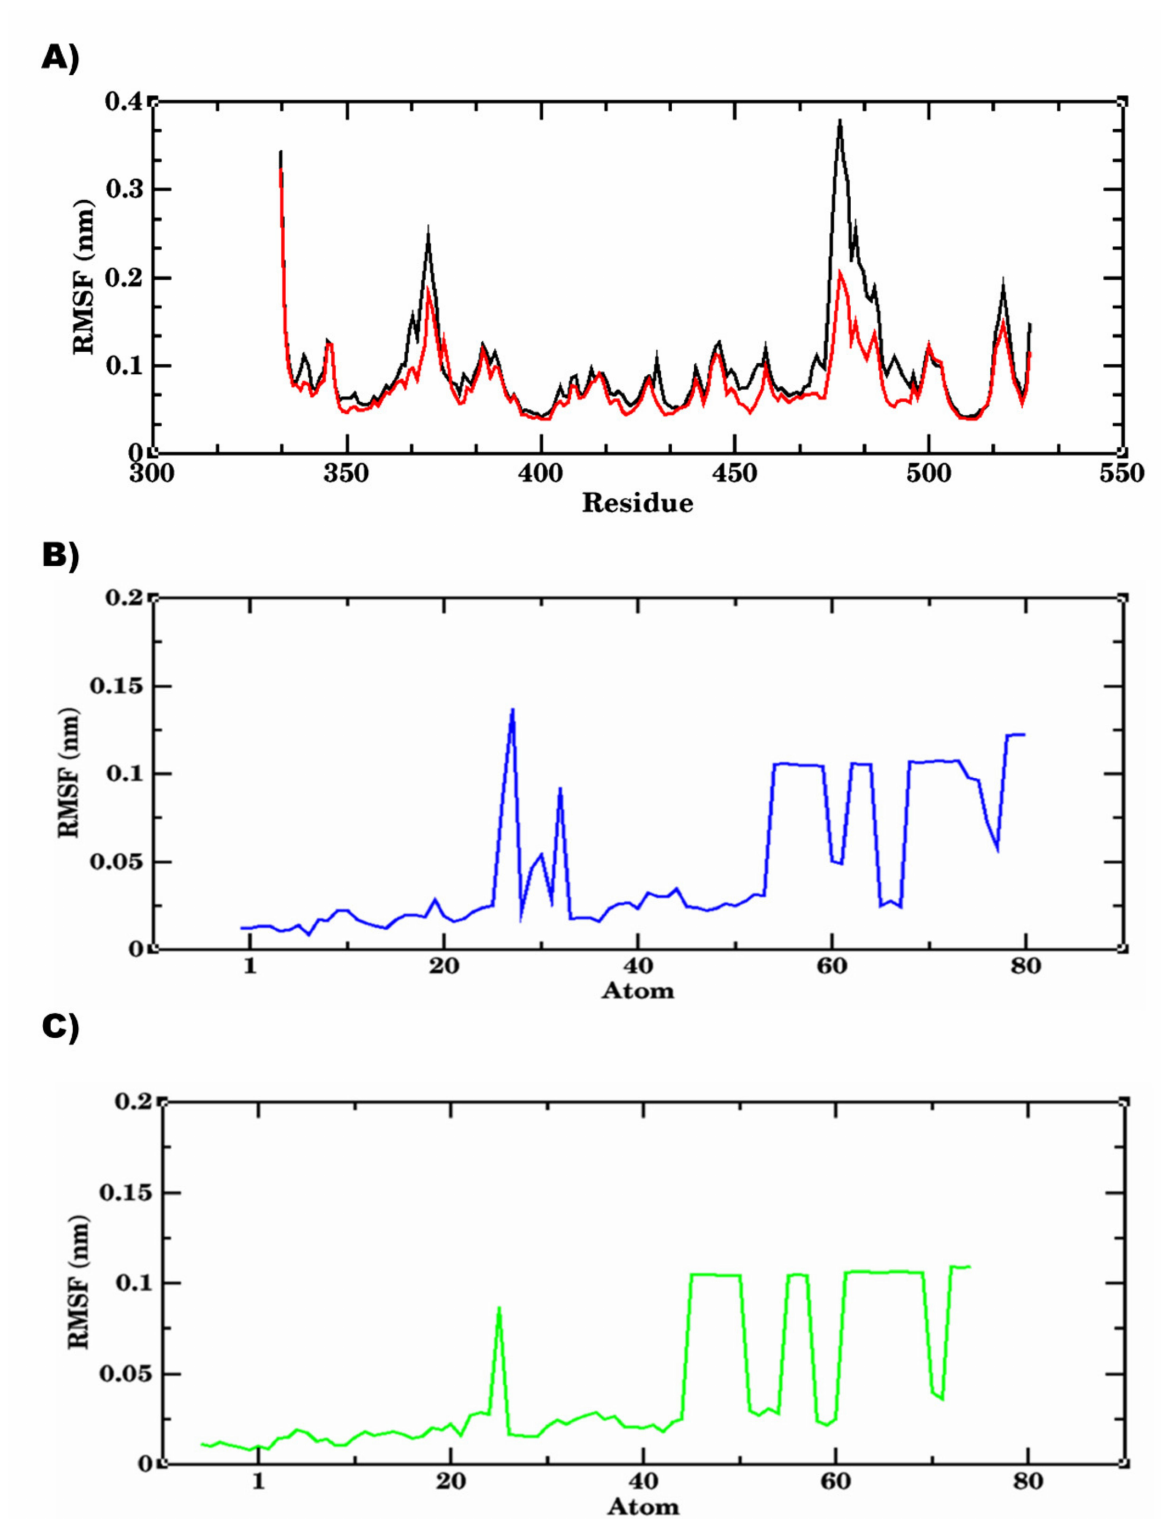
Figure 10. Protein backbone RMSF plot of 100, 000 ps MD simulation depicting the residue-wise fluctuations in the protein-ligand complexes against the RMSF values. ( A ) the residues of wild-type S RBD in complex with Lupeol (black) showed comparatively moderate fluctuations when compared to those of Delta S RBD (red) ( B ) RMSF of Lupeol (blue), showing minimum fluctuations and ( C ) the RMSF of Betulin (green), showing the lowest fluctuations, during the 100,000 ps